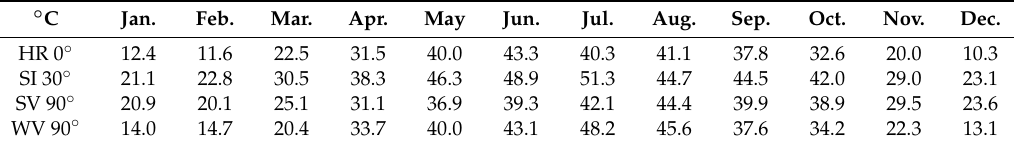
Table 4. Monthly averaged photovoltaic (PV) module surface temperature of each